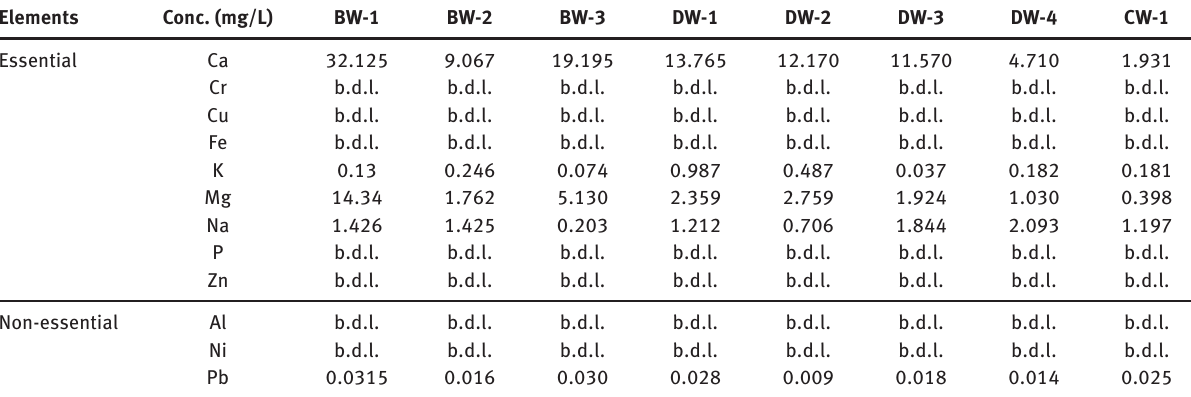
Table 3: The concentrations of essential and non-essential elements in water samples Elements